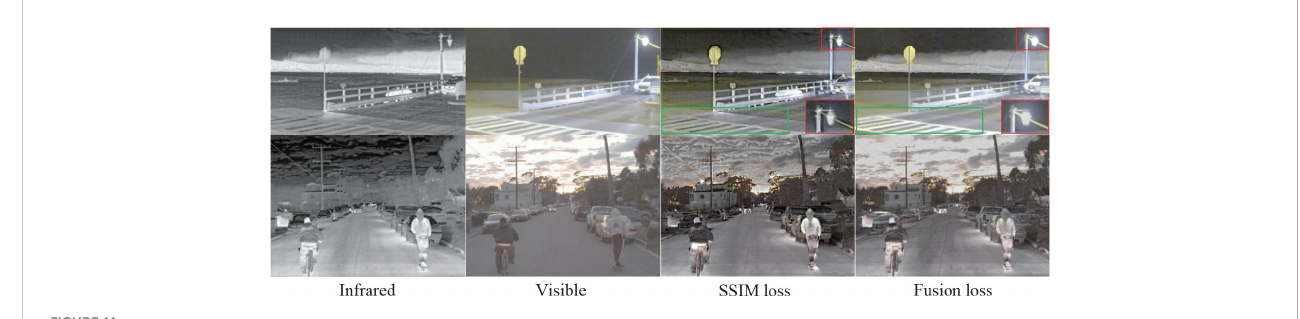
FIGURE 11 The results of RADFNet trained by SSIM loss L FS and Fusion loss L F .